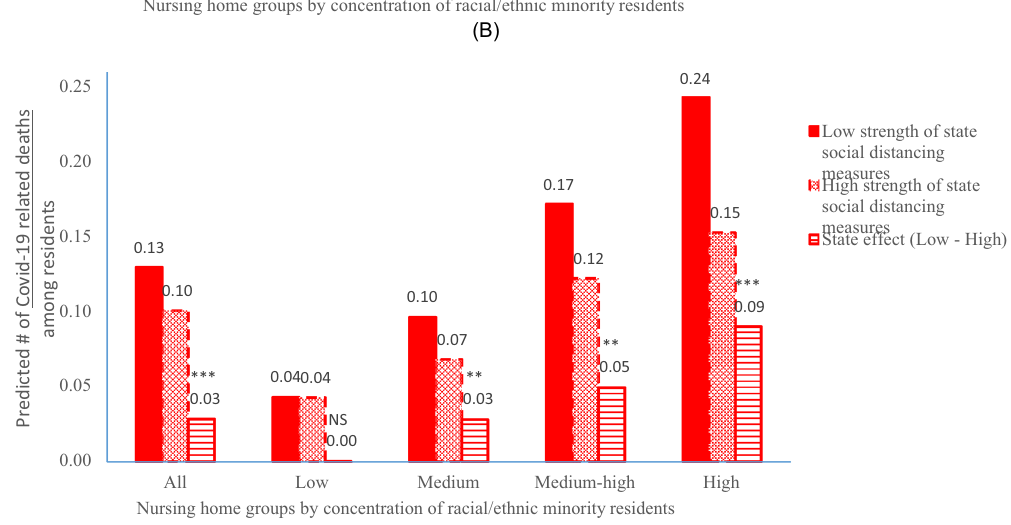
and by nursing home groups with different percentages of racial and ethnic minority residents. *p < 0.05, **p < 0.01, ***p < 0.001, and NS = not significant (p ≥ 0.05). P-values indicate the statistical significance of reductions in predicted numbers between nursing homes in states with high strength of social distancing measures and nursing homes in states with low social distancing measures, and were derived from the joint tests of the two-part regression models. Two-part models were used to derive the predicted numbers and their differences due to state policy effect. All two-part models adjusted for nursing home, county, and state covariates, time trend, and the clustering of repeated observations of nursing